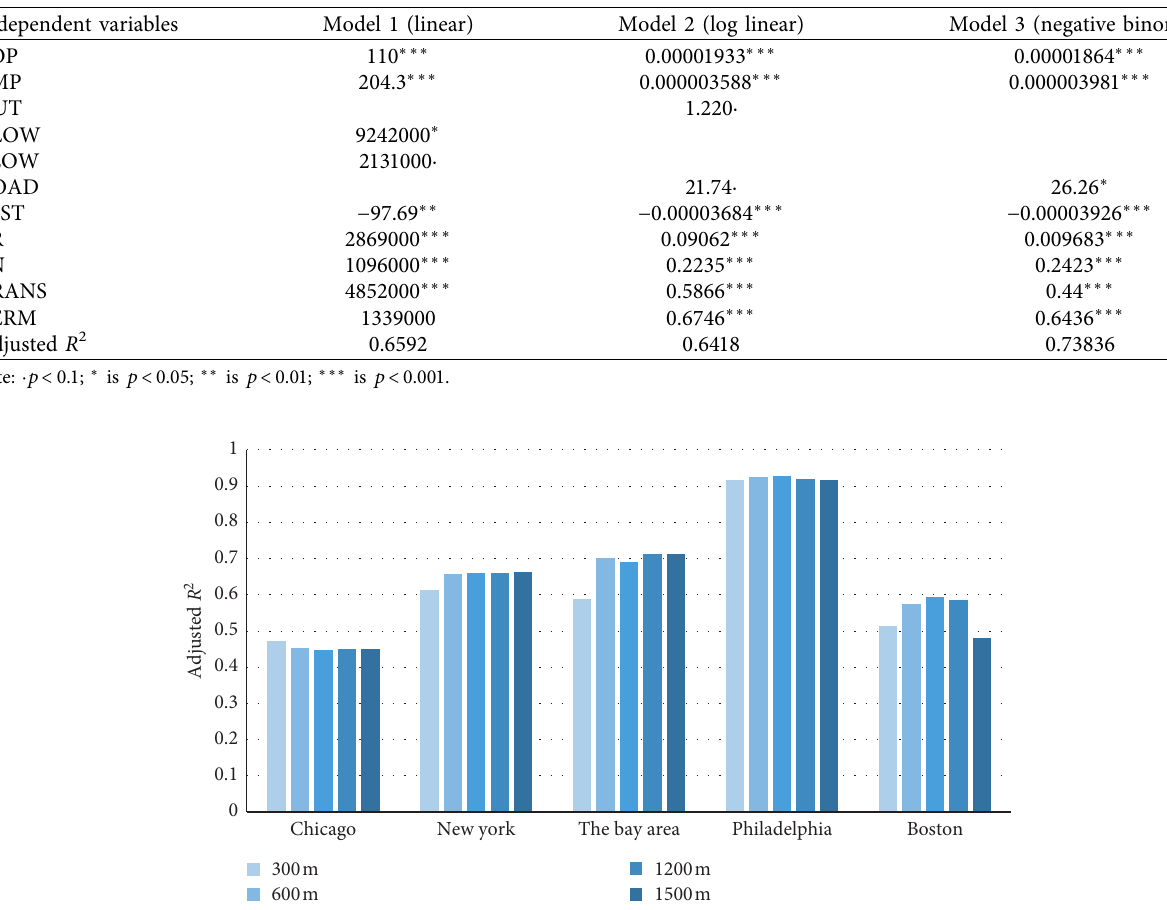
Table 3: Comparison of the results of three models of 900m Thiessen Polygon buffer area in New York.